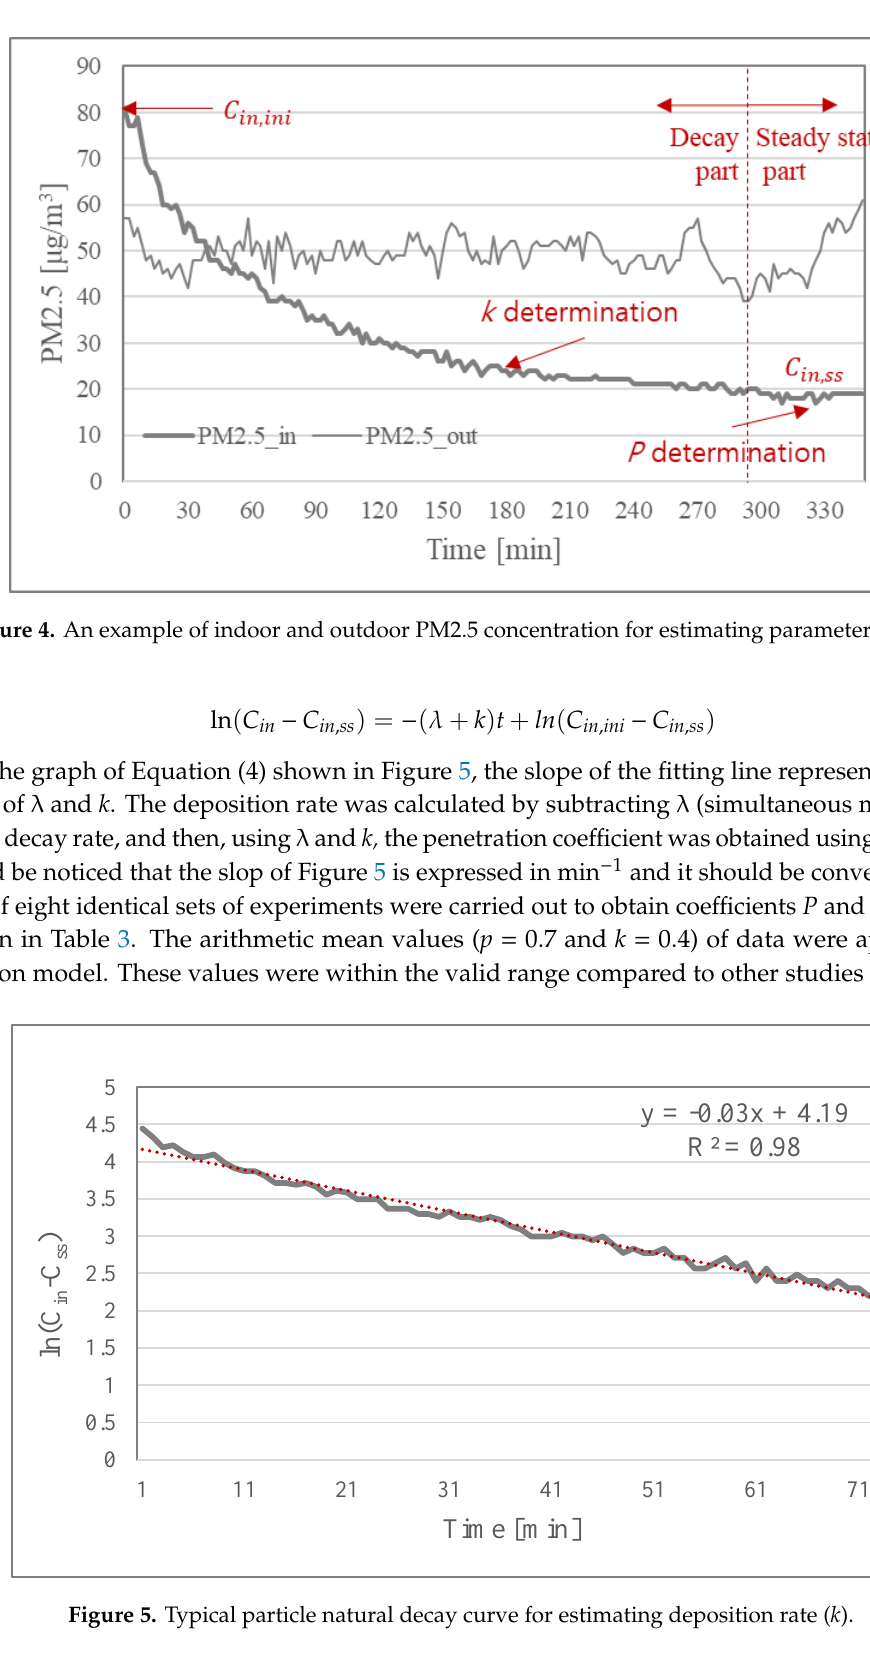
Figure 5. Typical particle natural decay curve for estimating deposition rate ( k ).